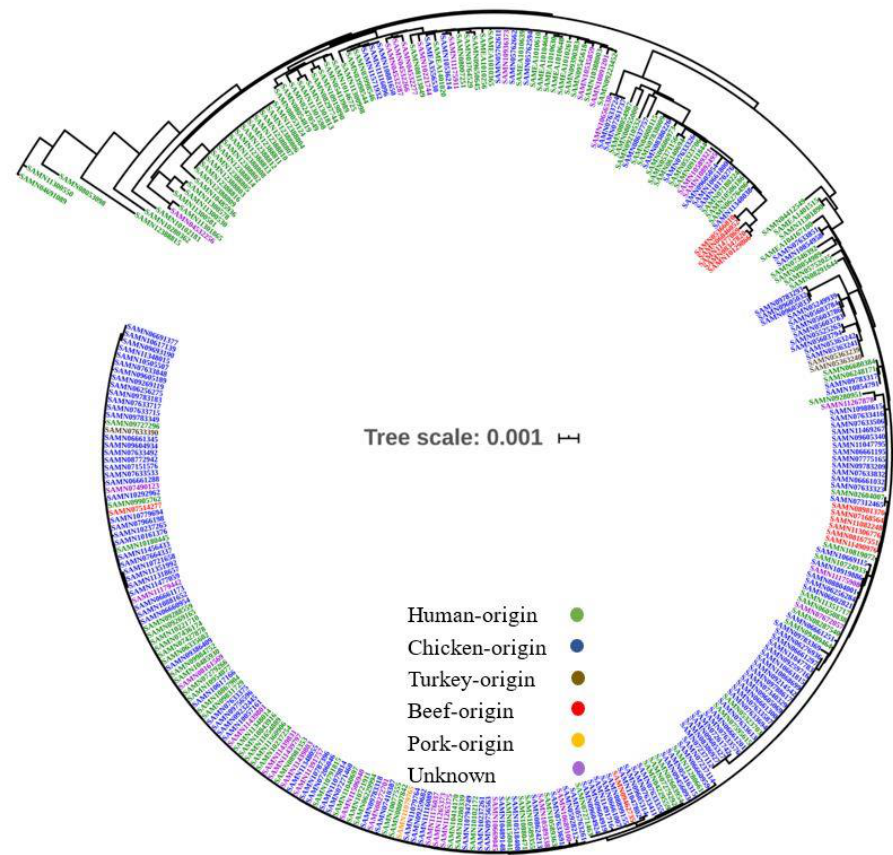
Figure 3. Phylogenomic tree of CC354 associated genomes in C. jejuni . Green color refers to human-origin isolates, blue color refers to chicken-origin isolates, orange color refers to pork-origin isolates, red color refers to beef-origin isolates, brown color refers to turkey-origin isolates and violet color refers to the unknown source.